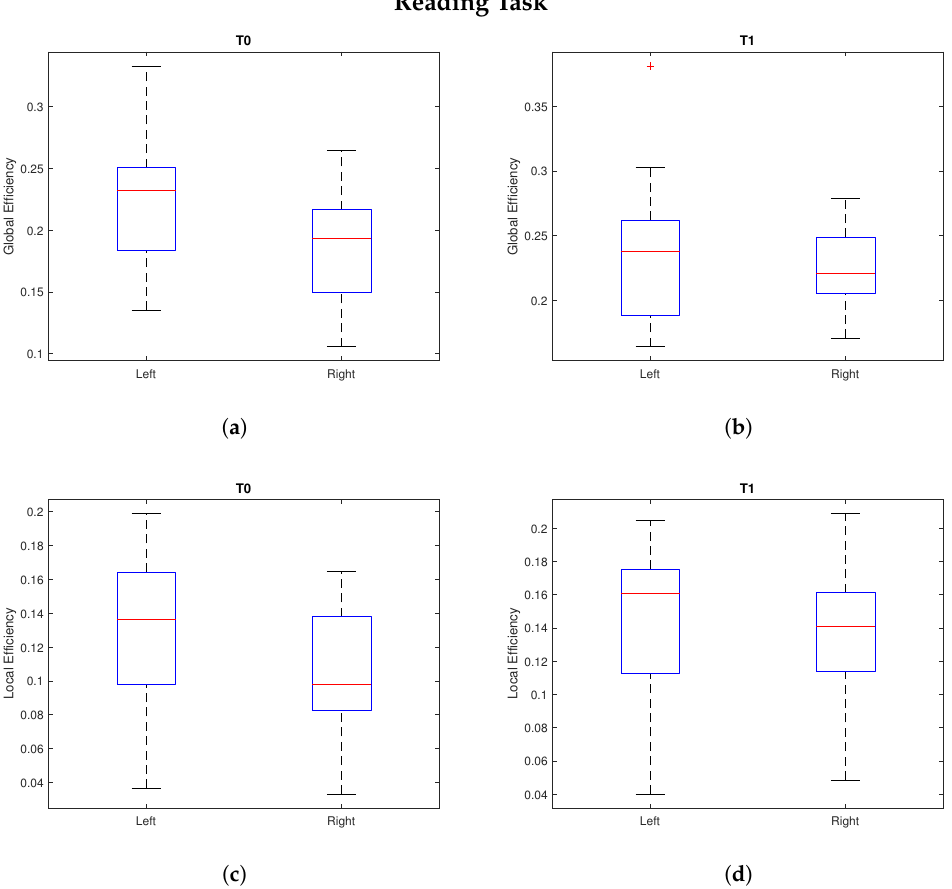
Figure 5. Reading task: boxplot of global efficiency for each hemisphere at time ( a ) T0 and ( b ) T1; boxplot of local efficiency for each hemisphere at time ( c ) T0 and ( d ) T1. On each box, the bottom and the top edges denote the 25th and 75th percentiles, respectively; the line inside the box indicates the median; the “whiskers” extend below and above the box up to the minimum and maximum data values, respectively. The ‘+’ marker symbol outside the whiskers represents the